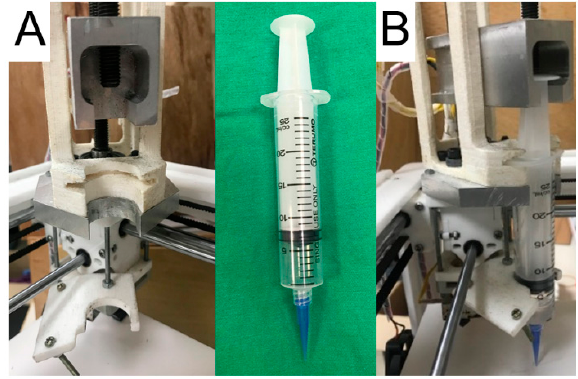
Figure 2. ( A ) Components of the dispensing unit in the solution extrusion additive manufacturing device, ( B ) assembly of the dispensing unit.